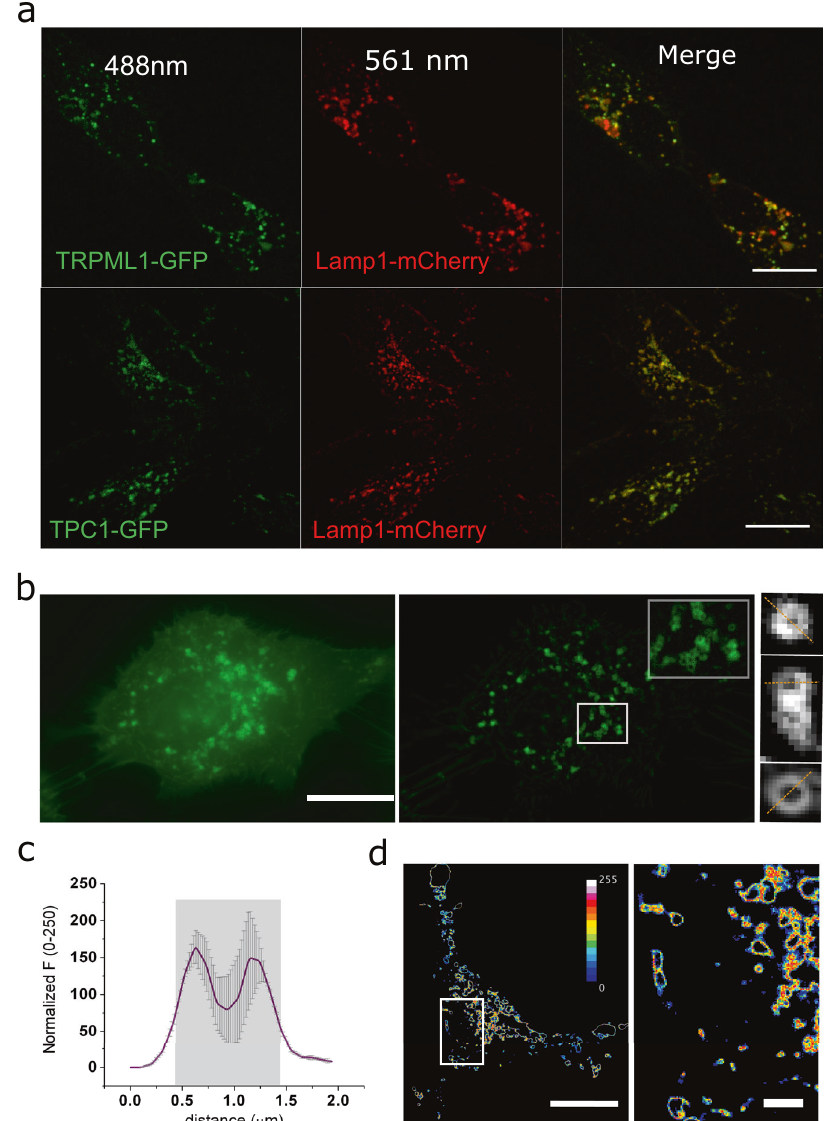
Fig. 2 Imaging of subcellular structures identi fi ed as lysosomes. a Representative colocalization images of the lysosomal marker Lamp1 with the lysosomal ion channels TPC1-EGFP and TRPML1-EGFP. Scale bars correspond to 5 μ m. b Raw image of a transiently transfected HEK293 cell expressing Lamp1-EGFP (left). FFT fi ltered and background-subtracted image (middle) allows the identi fi cation of individual lysosomes. Inset corresponds to a 6 × 6 µ m zoom of the highlighted area. An average of 10 frames allows obtaining better resolved individual lysosome structures (right panel). The orange lines indicate the axis used to extract the intensity pro fi le in Lamp1-positive objects. c Intensity versus distance plot showing the average size of lysosomes in the study. Gray values were collected along orange lines indicated in b . The average size of the doughnut-shaped objects was 112± 33nm ( n = 26). error bars correspond to SEM . d Mobility map of a cell expressing Lamp-EGFP (left; Scale bar, 10 μ m). The white square indicates the region zoomed on the right panel (Scale bar, 2 μ m). Red shades indicate zones with high motion and black represent regions containing immobile